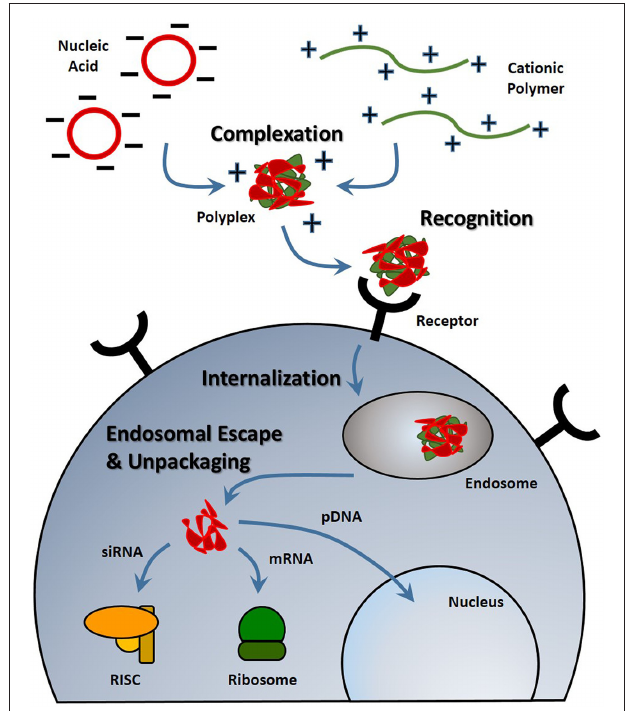
FIGURE 1 | Stages of nucleic acid delivery into a cell. Nucleic acids are typically condensed and complexed with a cationic material. This complex must be recognized by a cell, be internalized and escape the endosomal-lysosomal degradation pathway. Once in the cell cytoplasm, the nucleic acid can separate from its vehicle and traffic to its intended target based on its